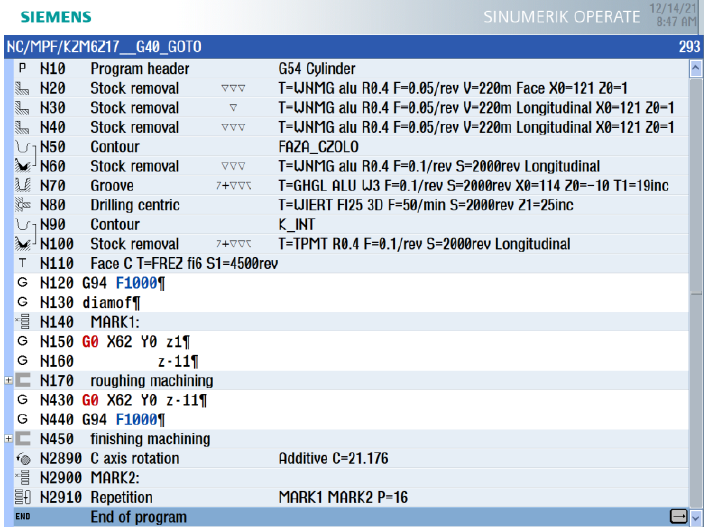
Figure 5. The machining program integrated with the Sinumerik 840 Dsl control system. Table 1. The machined gear parameters .